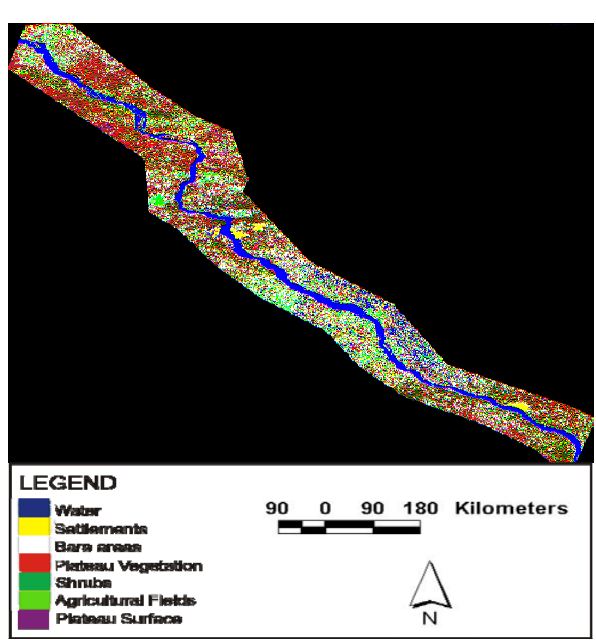
Figure 2.2: Classified Image of Landsat TM, 20